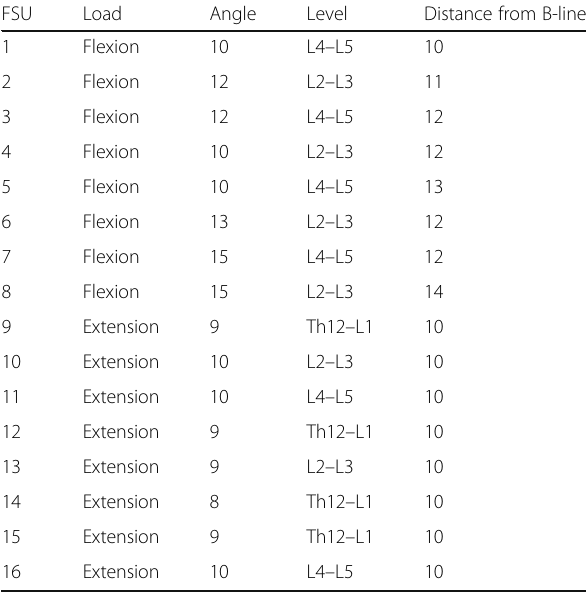
Table 1 Basic characteristics of the FSUs